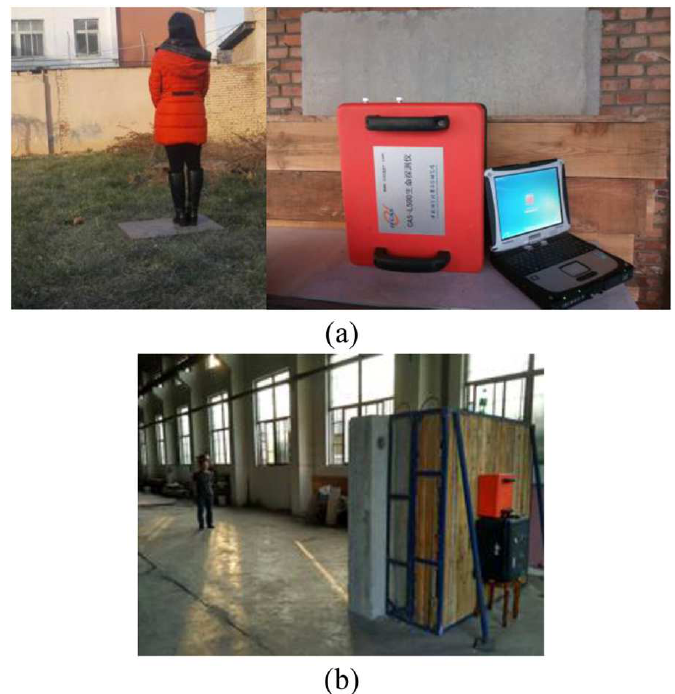
Figure 19. Vital sign detection experiments for a human subject by the UWB radar sensor: ( a ) outdoors and ( b ) indoors